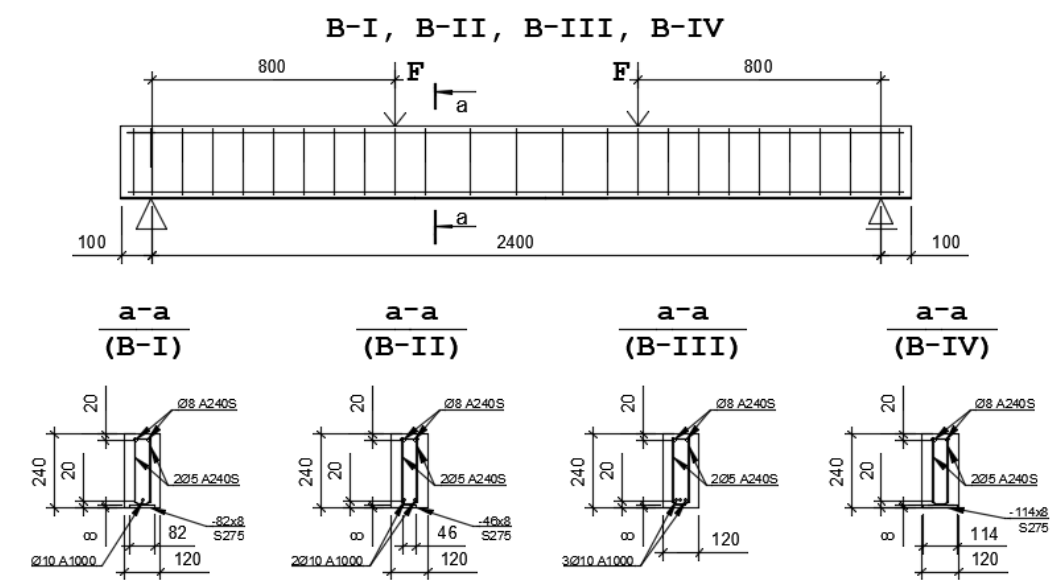
Figure 1. Construction of experimental beams’ frames.